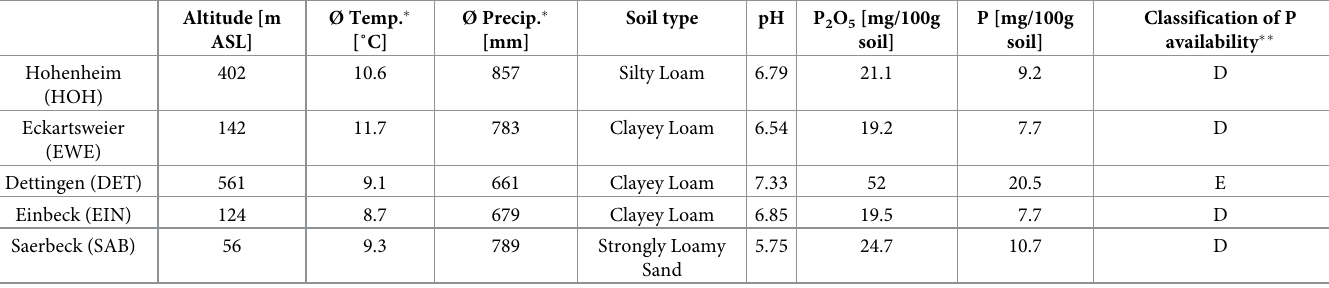
Table 1. Description of the locations. Altitude [m